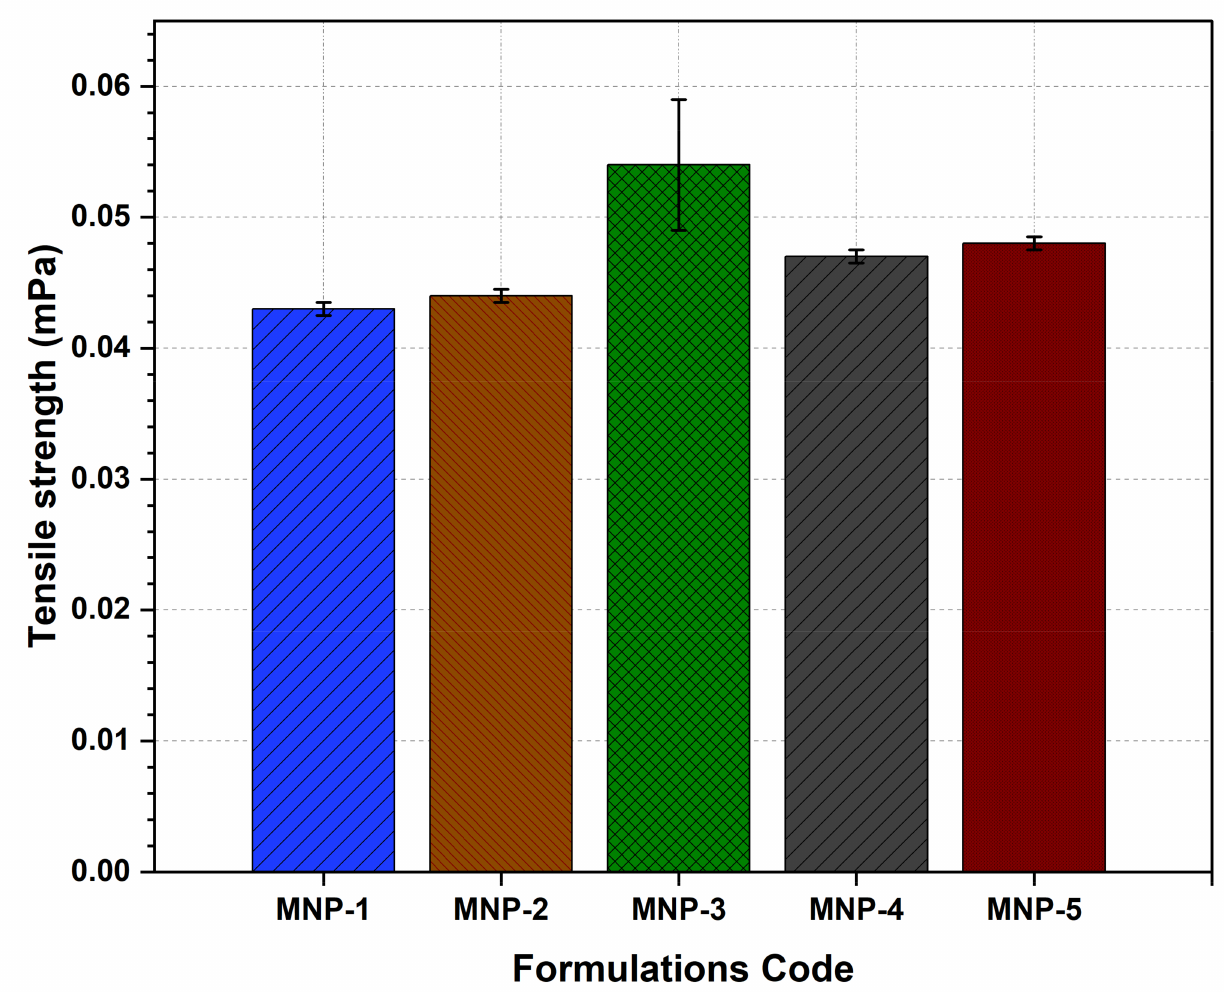
Figure 8. Evaluation of tensile strength of five different formulations of LS-TC-MNP fabricated with different concentrations of thiolated